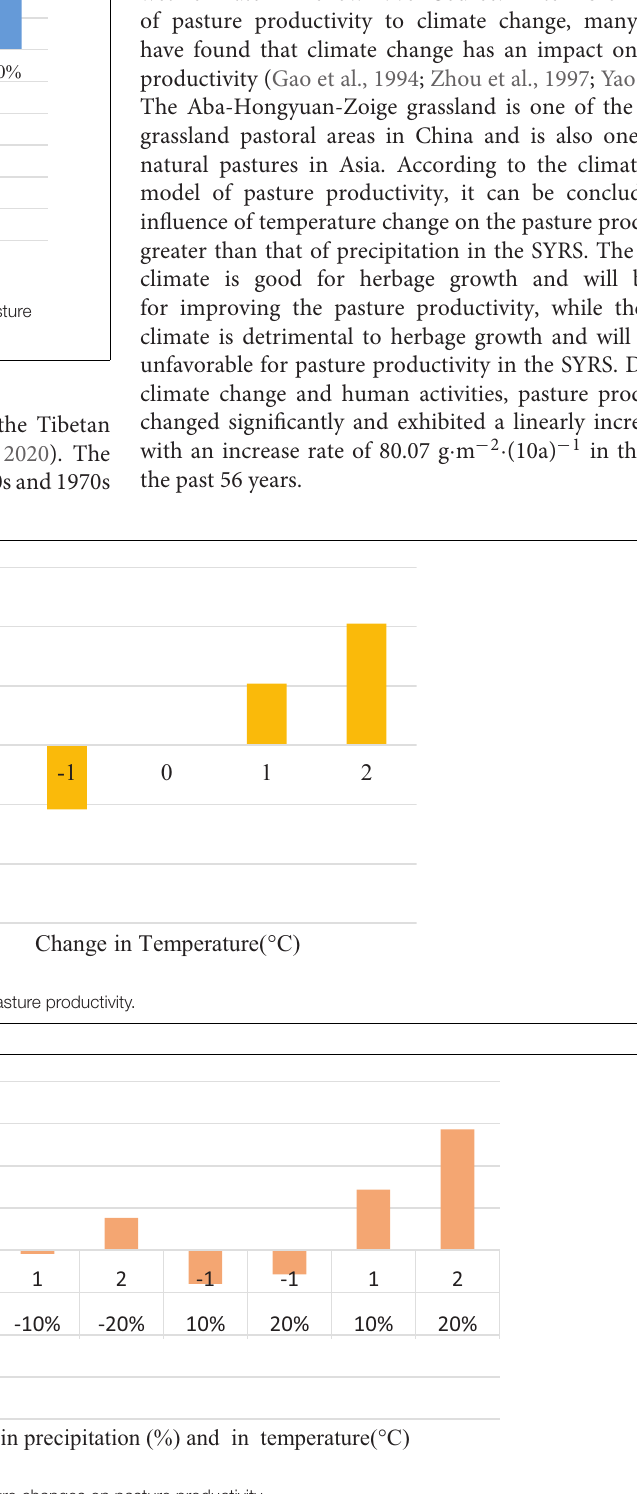
Frontiers in Ecology and Evolution |